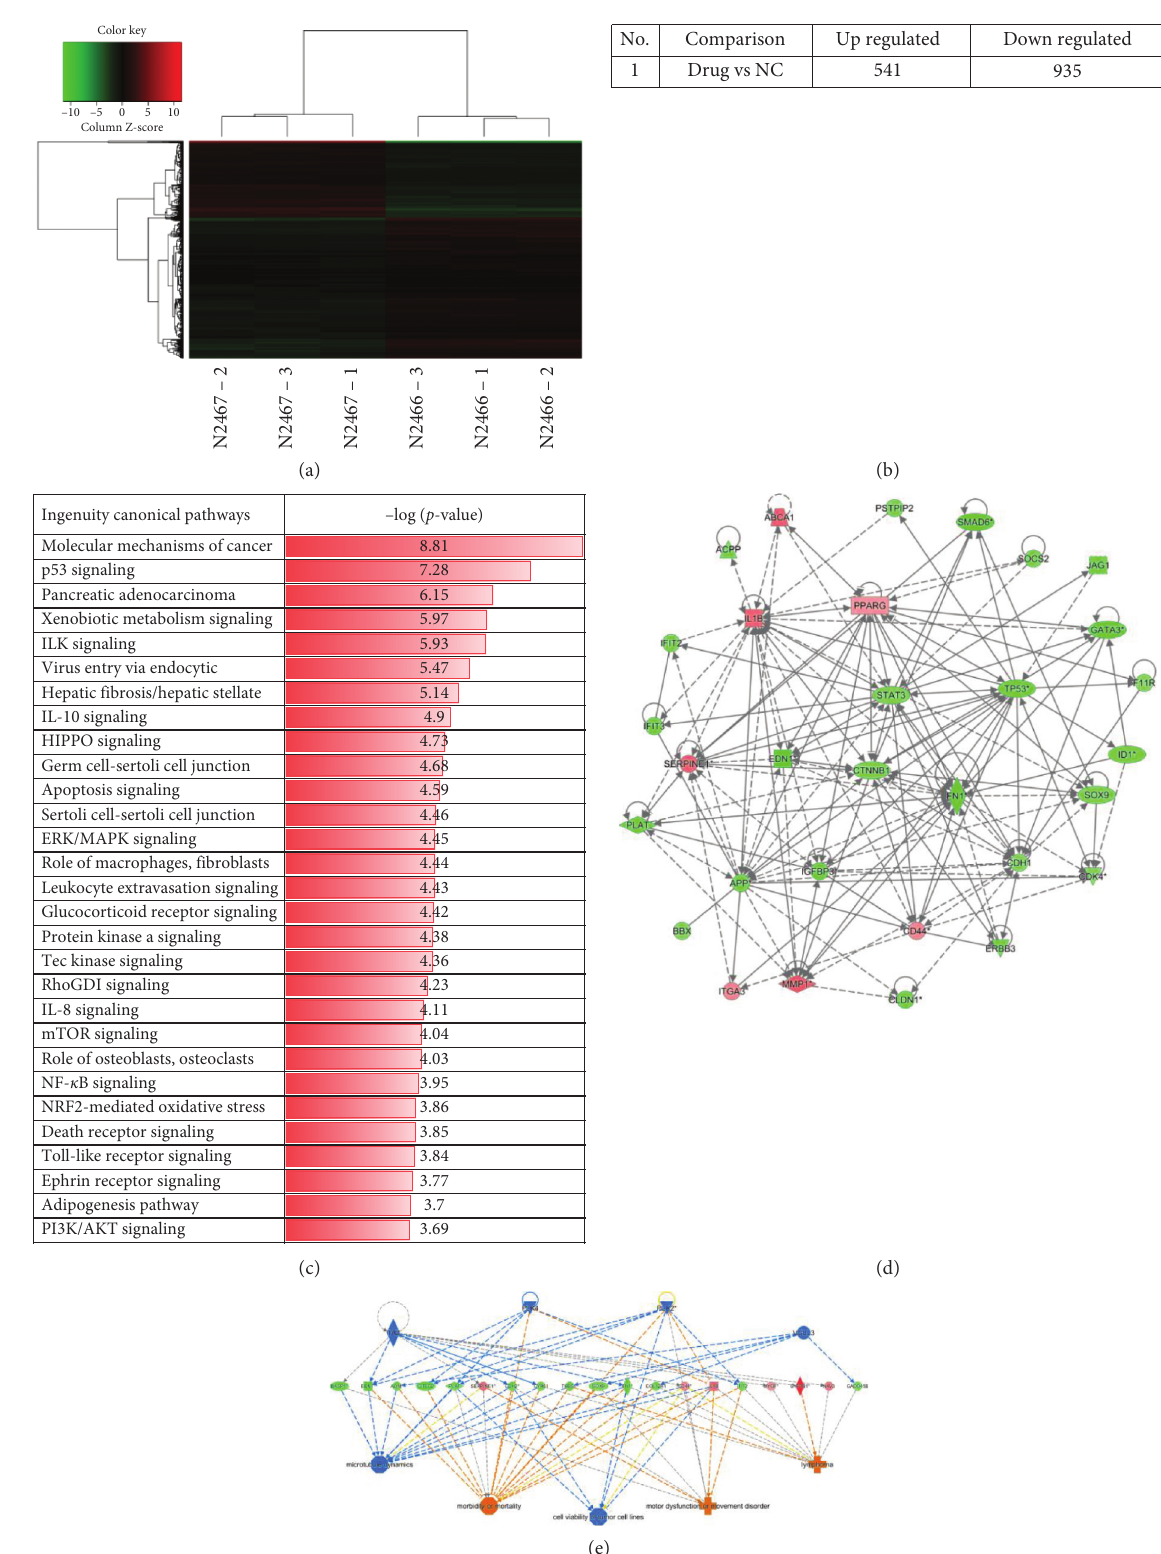
Figure 2: (a, b) 541 of 1476 DEGs were upregulated in HaCaTcells after PM2.5 stimuli, while 935 genes were downregulated. (c) Ingenuity canonical pathway analysis indicated inflammatory response-associated pathways are deregulated in PM2.5-treated HaCaTcells, like IL-10, IL-8, and NF- κ B signaling. The differential genes of different treatment groups were selected by the IPA grid algorithm to select genes with noticeable downstream changes. (d) Gene network, showing the interaction between different treatment groups through the grid diagram relationship. (e) The regulatory effect network map shows the interaction between genes and regulators and functions in the